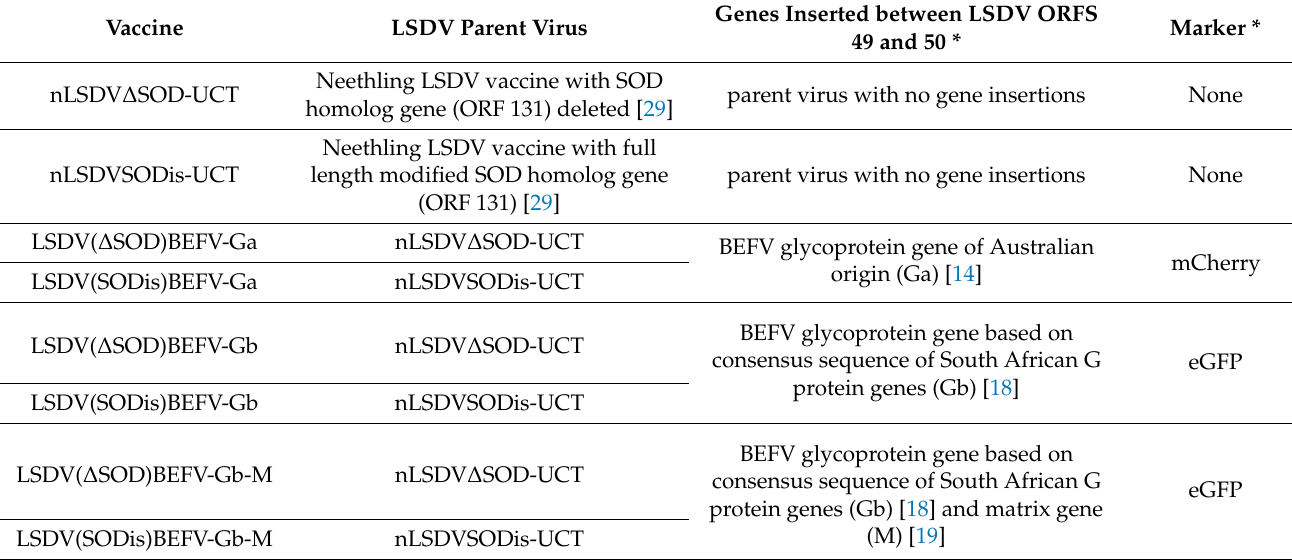
Table 1. Summary of components used in the construction of six different LSDV-BEFV dual